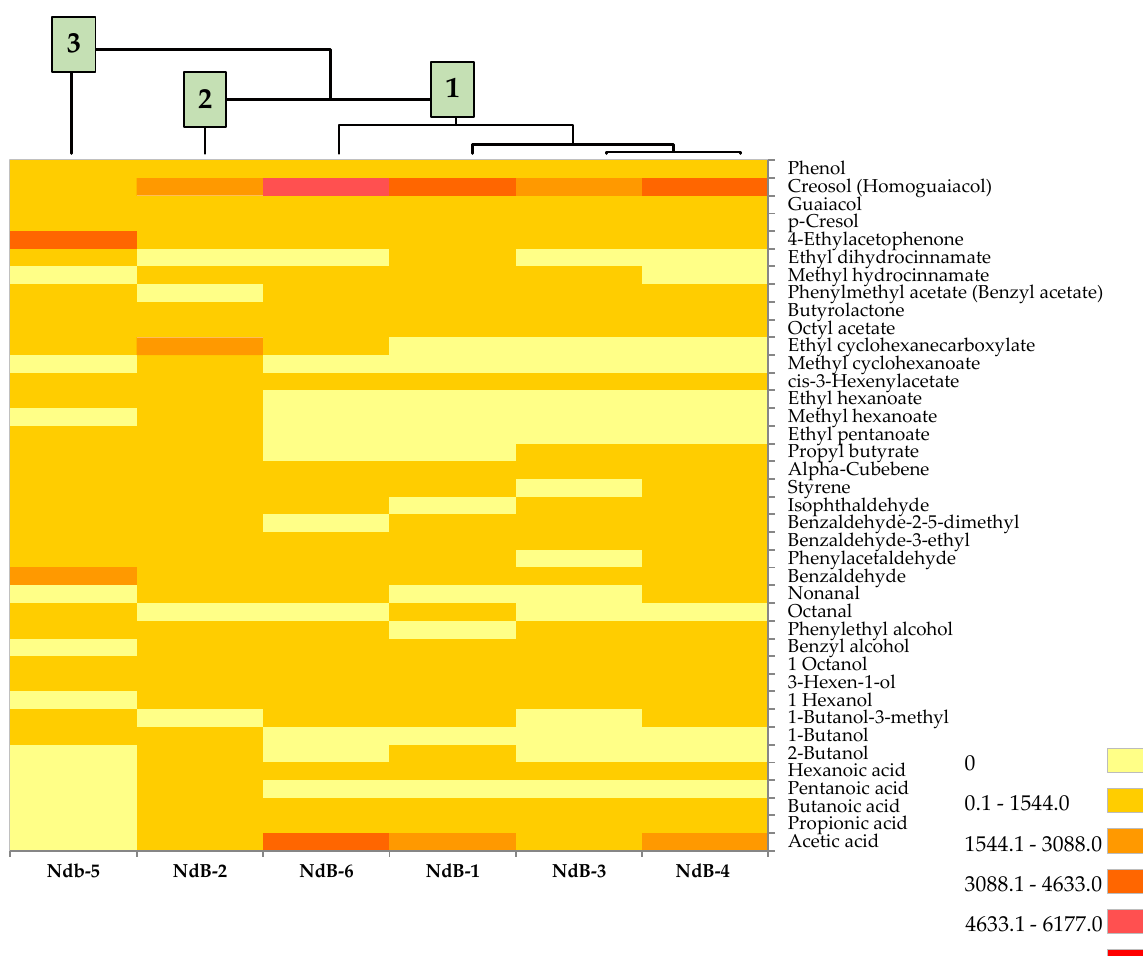
Figure 4. Distribution of volatile organic compounds within table olive experimental production. The relative concentration of each VOC is shown in the heat map plot for each trial. The hierarchical dendrogram is based on the values of VOCs. Abbreviations: NdB-1, spontaneous fermentation; NdB-2, L. pentosus OM13; NdB-3, L. pentosus OM13 + nutrient A; NdB-4, L. pentosus OM13 + nutrient B; NdB-5, L. pentosus OM13 + nutrient C; NdB-6, L. pentosus OM13 + nutrient D.